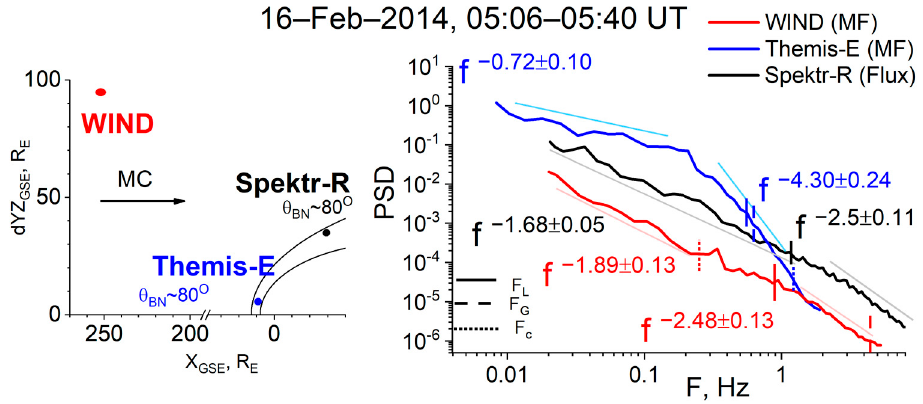
Figure 5. ( Left )—spacecraft positions; ( right )—comparison of the normalized Fourier spectra for the SW of type MC.